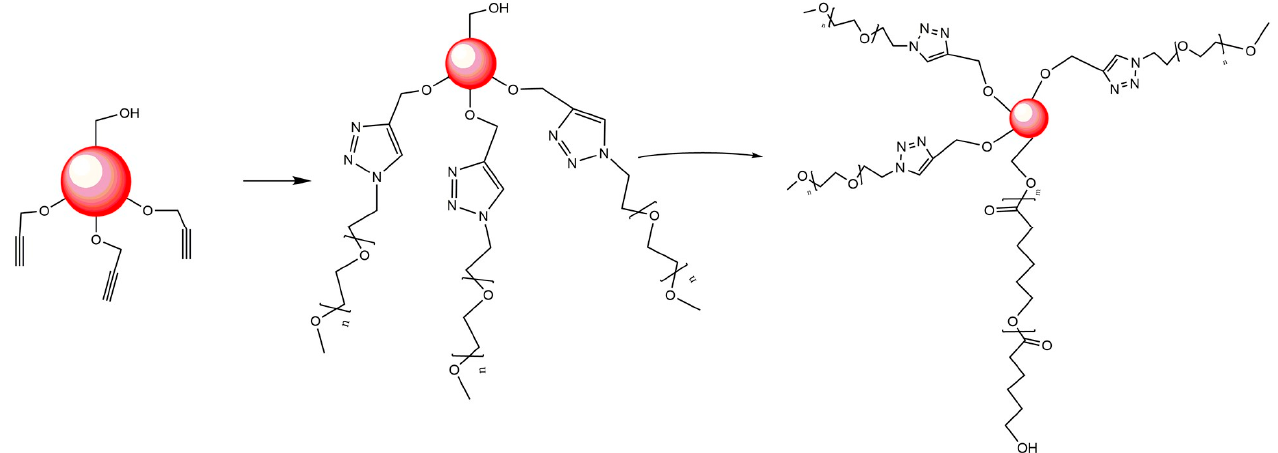
Figure 9. Synthesis of AB 3 -type multi-arm polymers based on PCL-PEG.